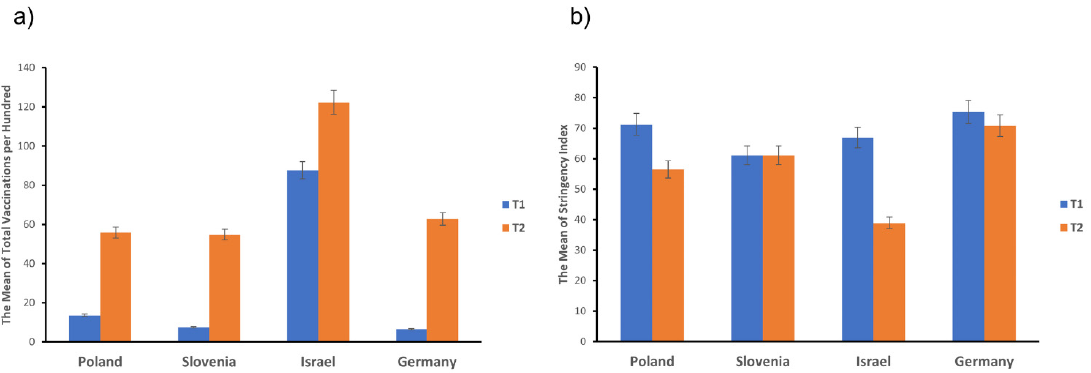
Figure 1. The mean scores at the first measurement (T1) in February 2021 and the second measurement (T2) in May–June 2021 of: ( a ) total vaccinations per hundred in Poland, Slovenia, Israel, and Germany; calculation based on Our World in Data panel [25]. ( b ) The Stringency Index; calculation based on the Oxford COVID-19 Government Response Tracker (OxCGRT) [25,26].